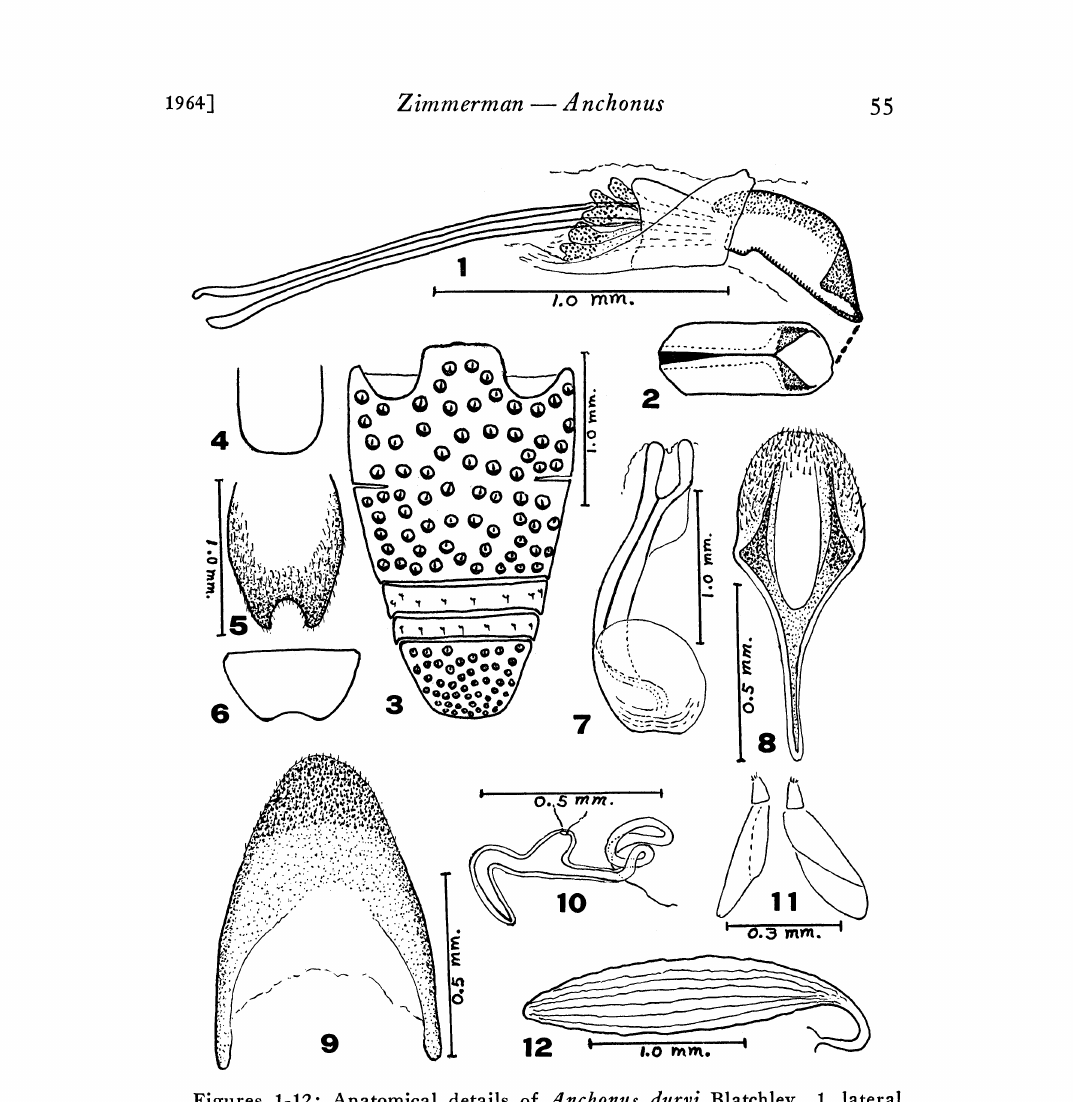
Figures 1-12: Anatomical details of Anchonus duryi Blatchley. 1, lateral view of aedeagus with phallobase ("tegumen") in situ (note lack of well- developed apodemes of phallobase) 2, dorsal view of apical part .of aedeagus drawn to same scale as 1; 3, ventral view of abdomen o female; 4, outline of pygidium of male; 5, pygidium of female; 6, outline of ventrite five of male (compare shape of caudal margin with that of female); 7, urosternite ("spiculum gastrale") .of male; 8, urosternite of female; 9, eighth tergite of female; 10, spermatheca (the convolutions vary) 11, lobes of ovipositor; 12, the single ovary (this is sclerotized and is unusual because it persists after digestion in KOH). The male specimen used for these drawings is from Tahiti; the female came from Florida, U. S.